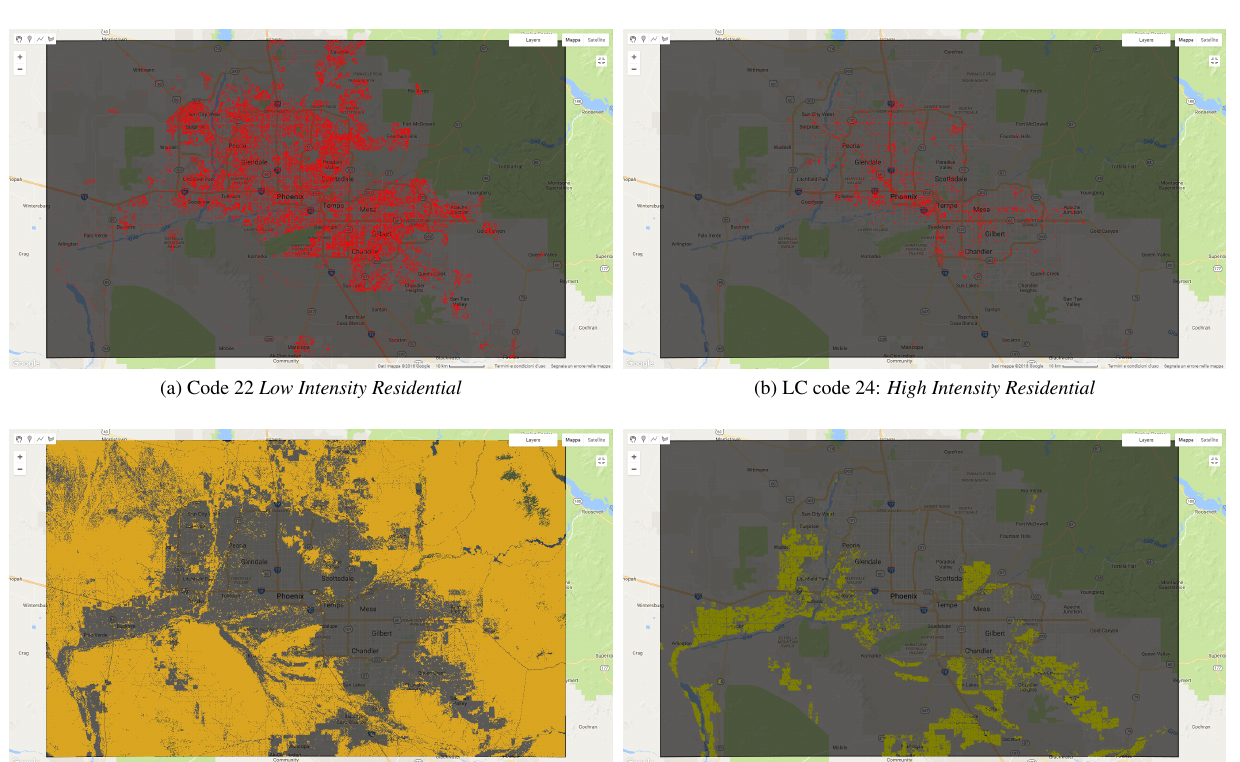
Figure 9: 1992 spatial distribution of LC classes within the ROI.